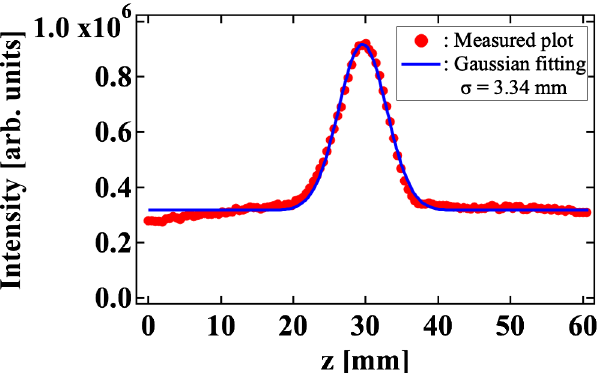
FIG. 10. An example of the product of the detection efficiency distribution and the gas density distribution along the z axis at the center of the H − beam trajectory. The inlet pressure of the gas sheet generator is 100